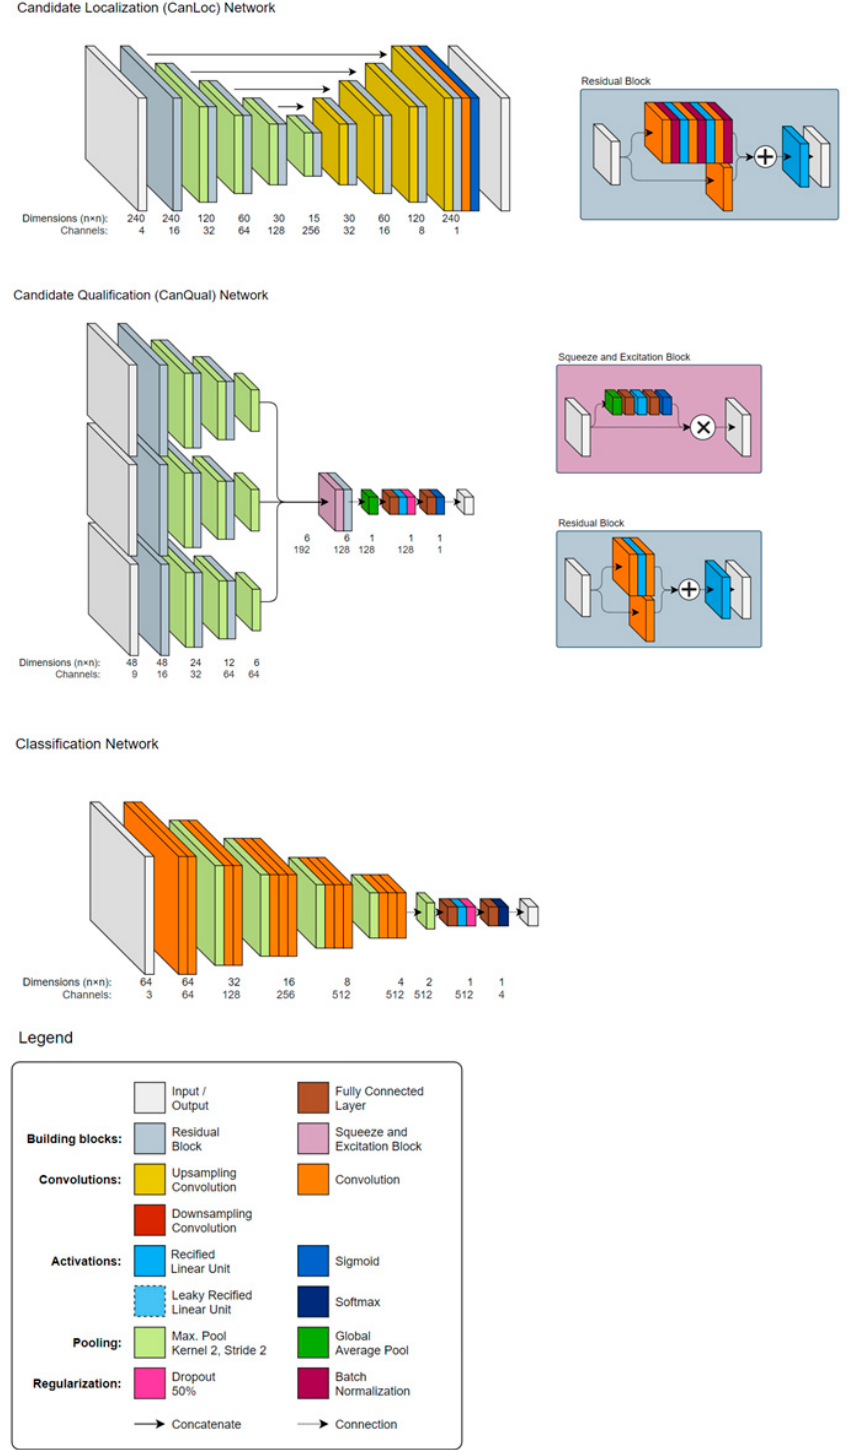
Figure 1. Network architecture of the autonomous Prostate Imaging Reporting and Data System (PI-RADS) lesion detection and classification software solution consisting of a sequence of coupled deep neural networks: a localization network (CanLoc), a candidate qualification network (CanQual)— named false-positive-reduction (FPR) network in Figure 2—and the classification network.